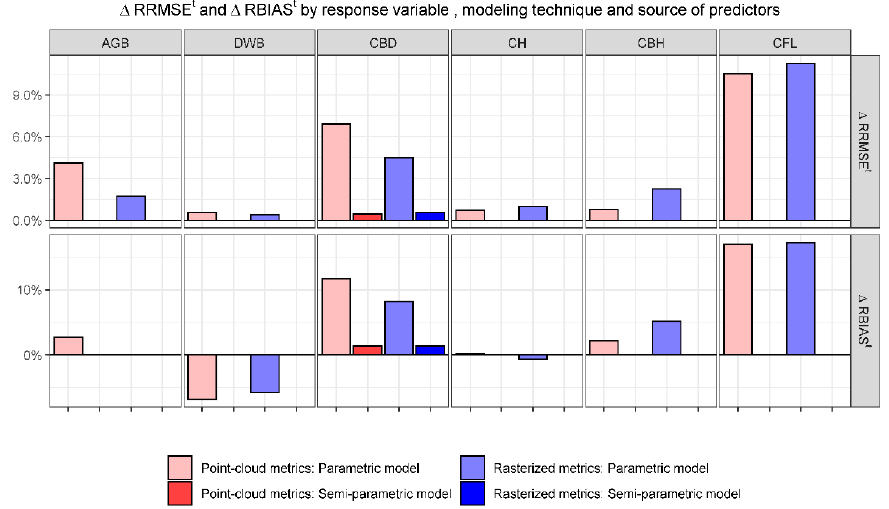
Figure 4. Changes in relative root mean square error ∆ RRMSE t and relative bias ∆ RBIAS t due to calibration. Positive values indicate improvements. AGB, DWB, CBD, CH, CBH, and CFL respectively indicate aboveground biomass, downed woody biomass, canopy bulk density, canopy height, canopy base height, and canopy fuel